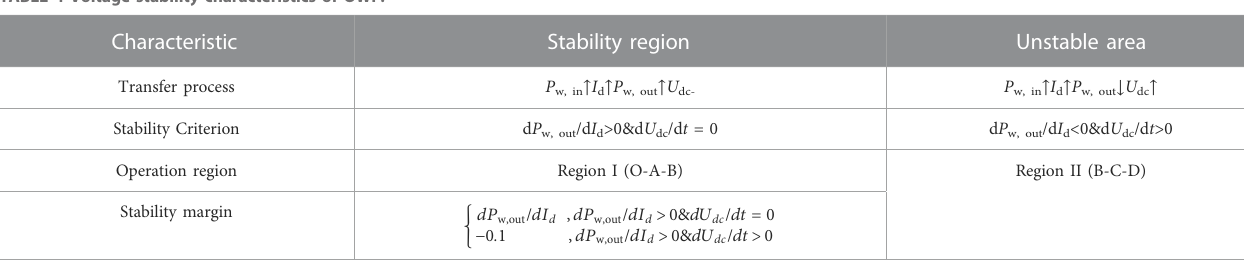
TABLE 4 Voltage stability characteristics of